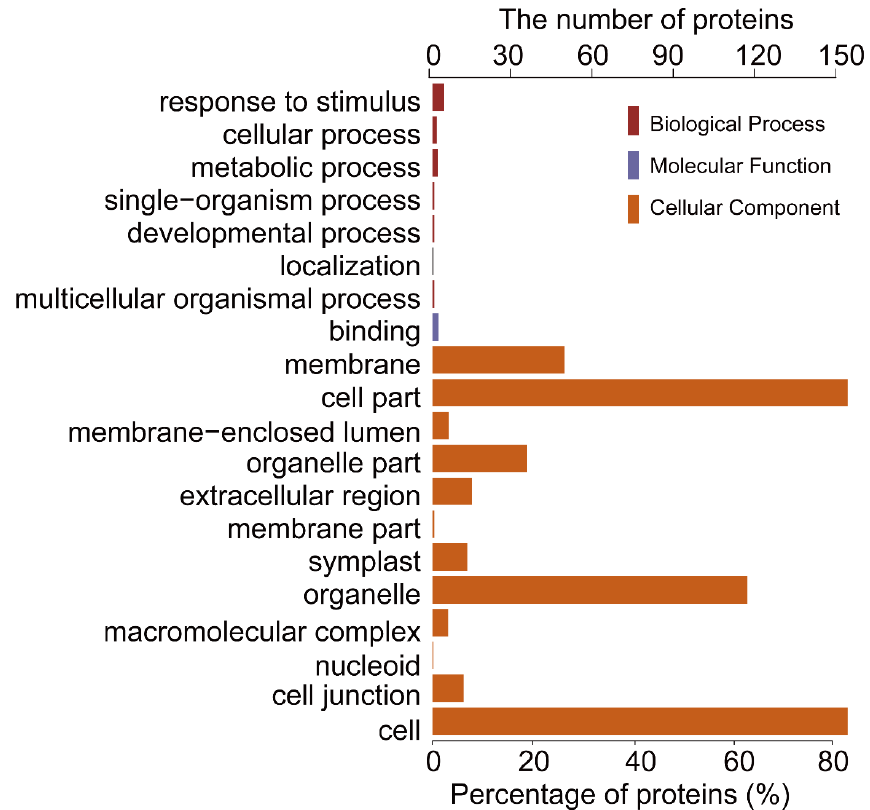
Figure 3. Gene ontology (GO) analysis of salt tolerance (STO)-dependent UV-B-induced proteins. GO analysis (gene ontology) describes the properties of genes and gene products in organisms from three aspects: the biological process (BP), the molecular function (MF), and the cell component (CC).